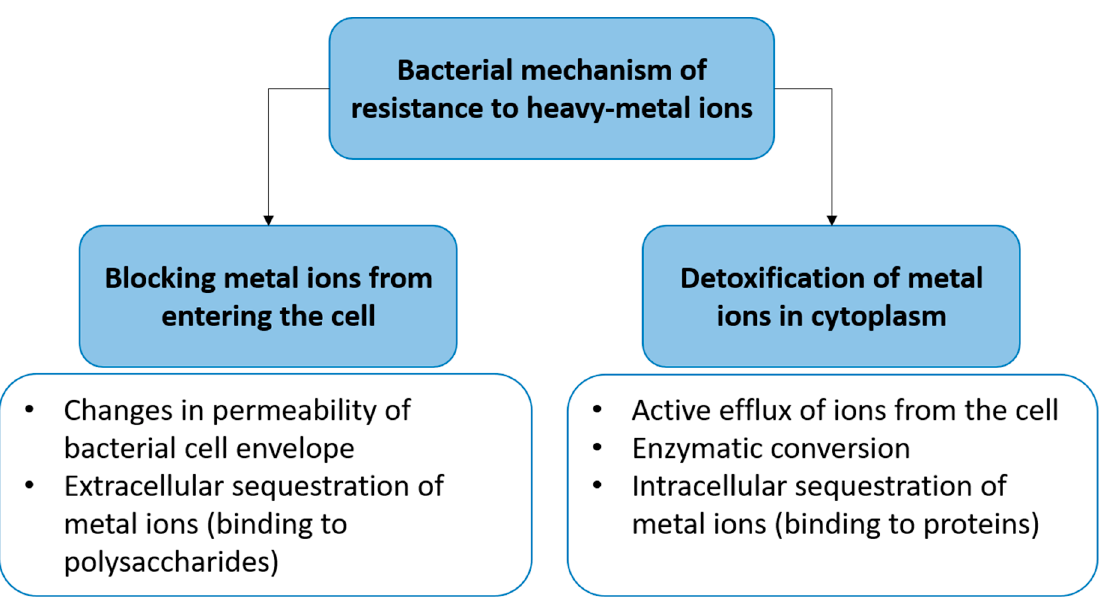
Figure 4. Diversity of bacterial mechanisms of resistance to heavy metals [71].